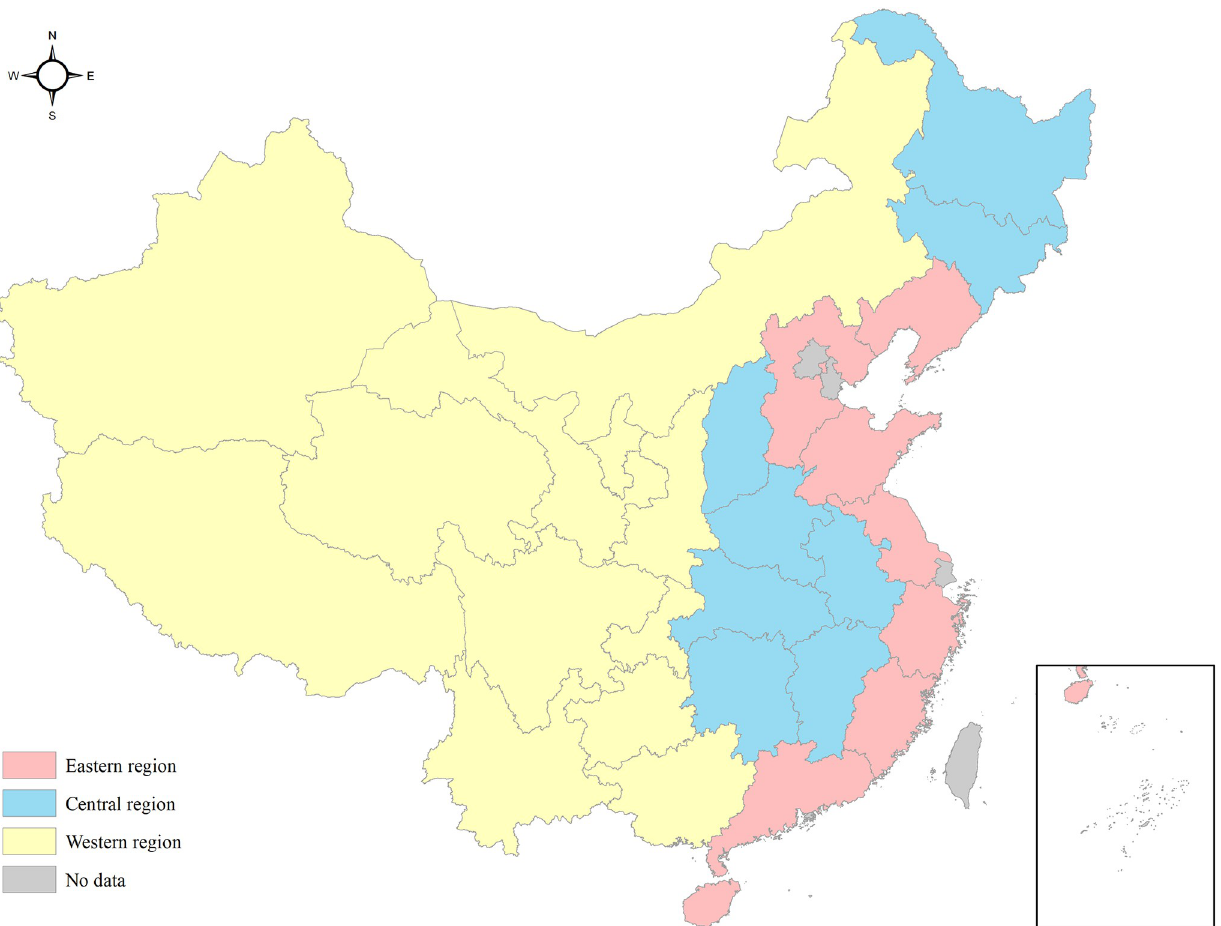
Fig 1. Study sites in this research. This figure is drawn based on the standard map from Resource and Environment Science and Data Center (https://